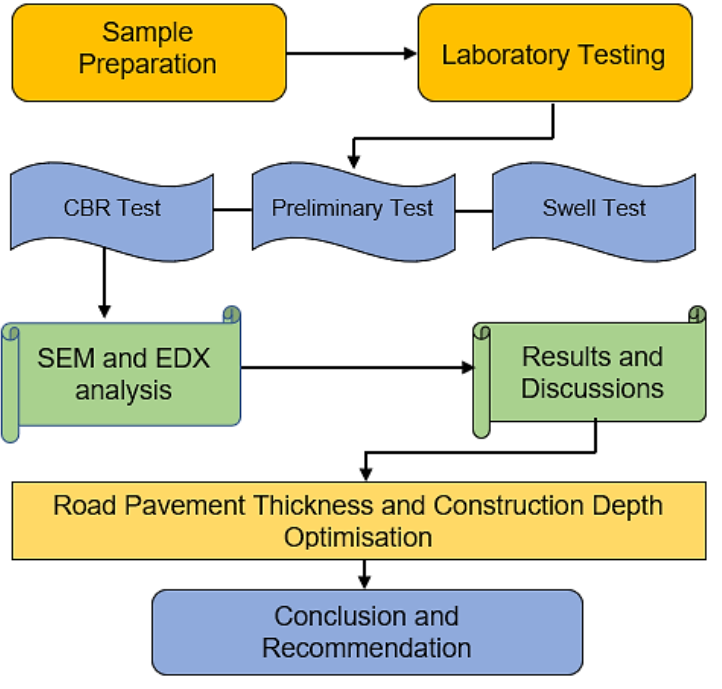
Figure 3. Methodological process.